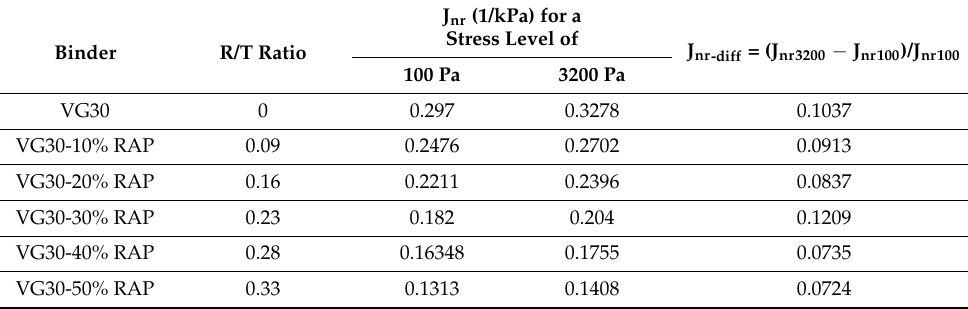
Table 8. MSCR Test